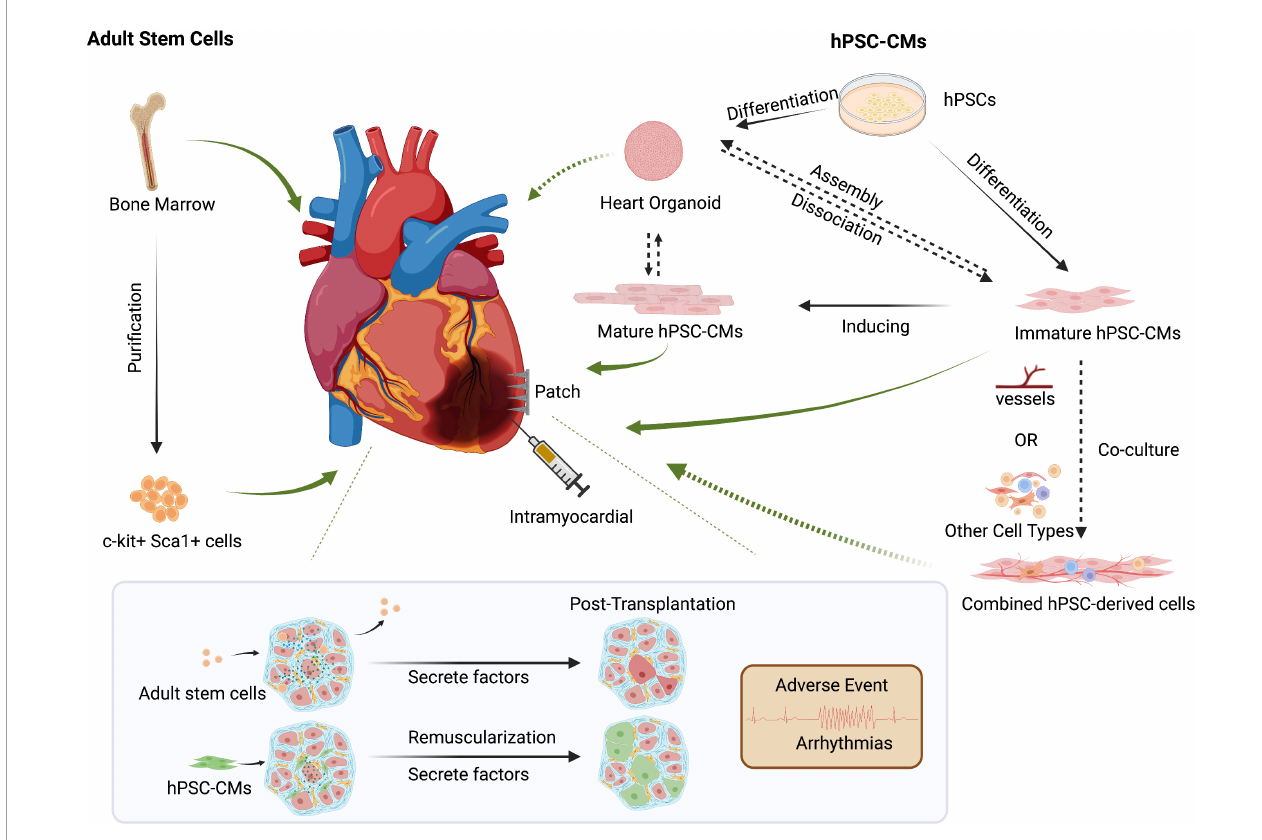
FIGURE2 Cell-based approaches to cardiac regenerative medicine. Delivery methods such as intracardiac injection and cell patches can be used for cell-based therapies. Though controversial, transplanting bone marrow-derived adult stem cells could promote cardiac function via secreted factors. Human pluripotent stem cell-derived cardiomyocytes (hPSC-CMs) can repair damaged hearts through tissue replacement of lost cardiomyocytes and help promote cardiac function by secreting growth factors such as VEGF. However, preclinical models and clinical trials must carefully address post-transplant arrhythmias and other side effects. The increased maturity of hPSC-CMs might reduce unwanted and potentially lethal arrhythmic events. Co-delivery of multiple cell types, including endothelial cells or other cardiac cell types, might improve hPSC-CMs retention and thereby promote the repair of injured hearts. Created with